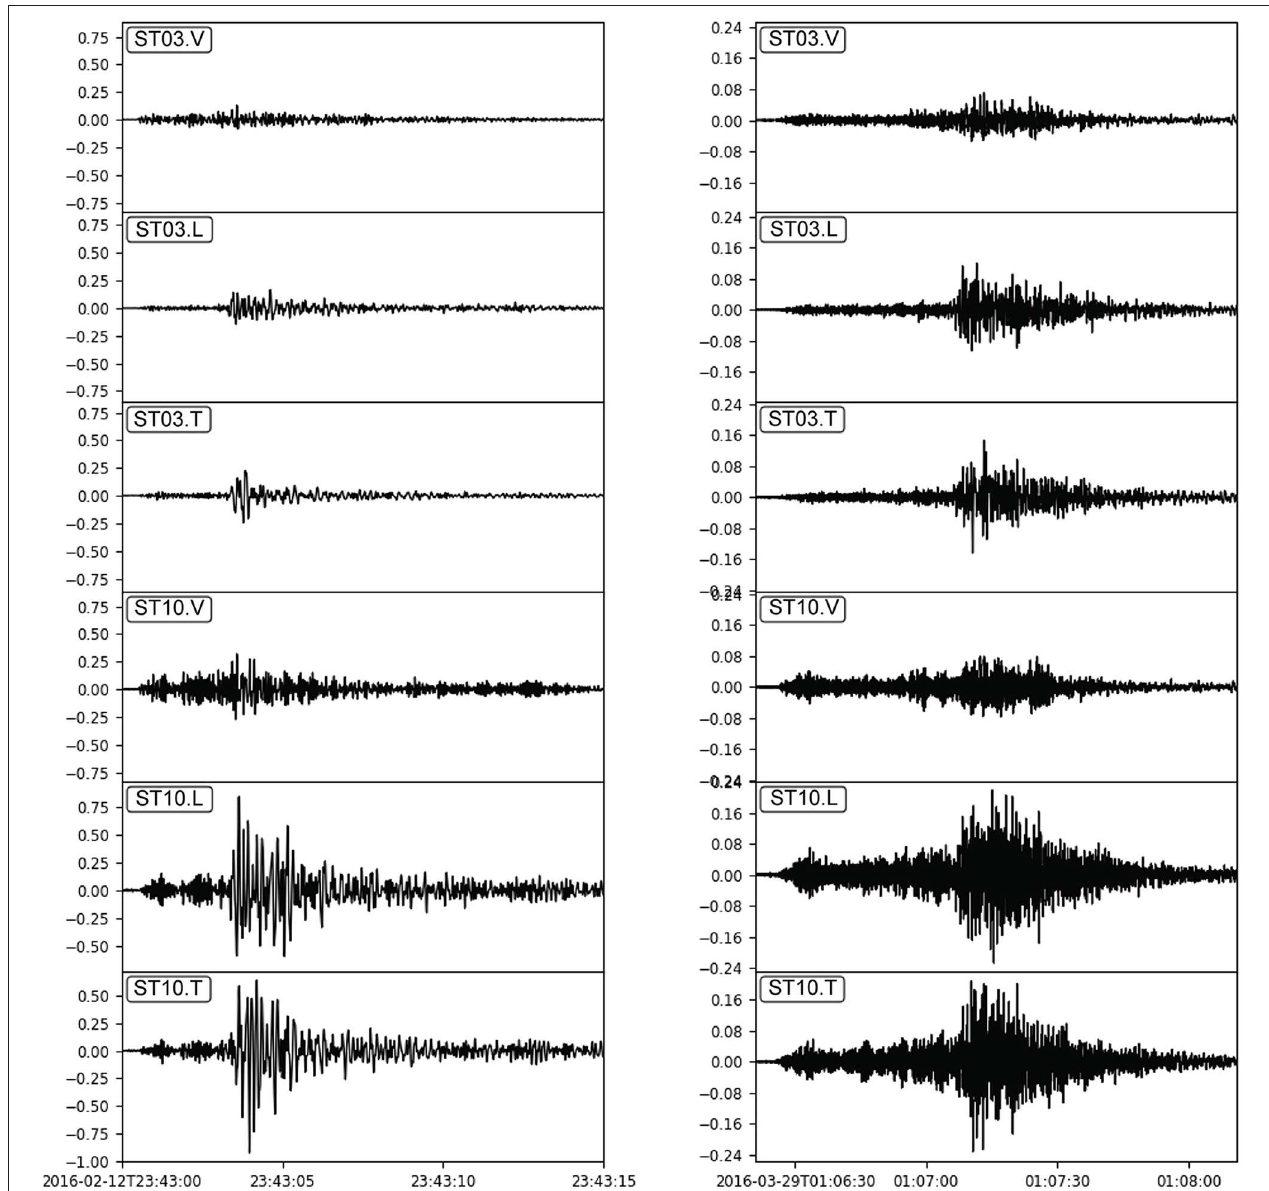
FIGURE 10 | Time histories of acceleration (in cm/s 2 ) recorded at the base (ST03) and at the last floor (ST10) (cf. Figure 8 ) during a M L 2.4 earthquake, occurred at epicentral distance of about 18km (boxes on the left), and a M W 5.2 earthquake, at about 396km (boxes on the right).